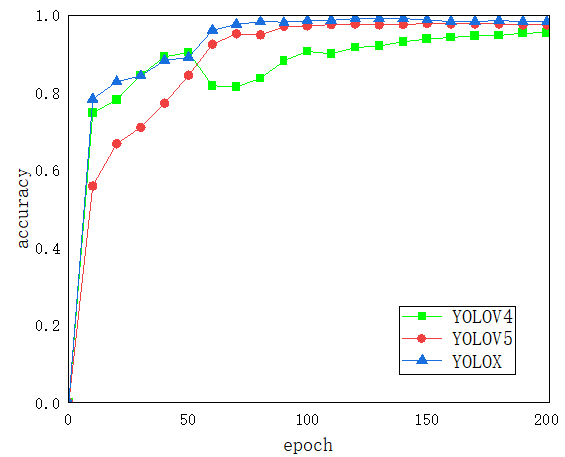
Figure 9. Comparison of training and testing loss. ( a ) YOLOV4; ( b ) YOLOV5; ( c ) YOLOX.